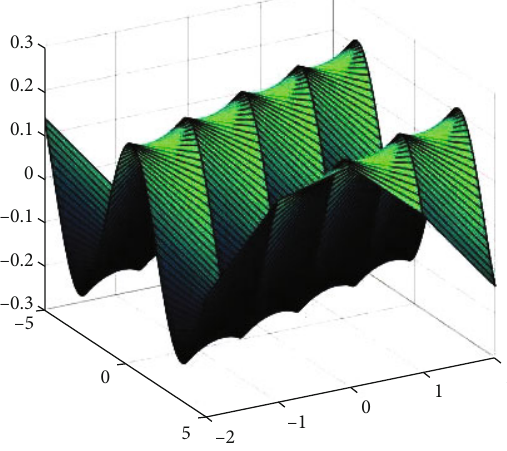
Figure 3: Analytical result of μ ð χ , ξ , I Þ at δ = 0 : 4 of